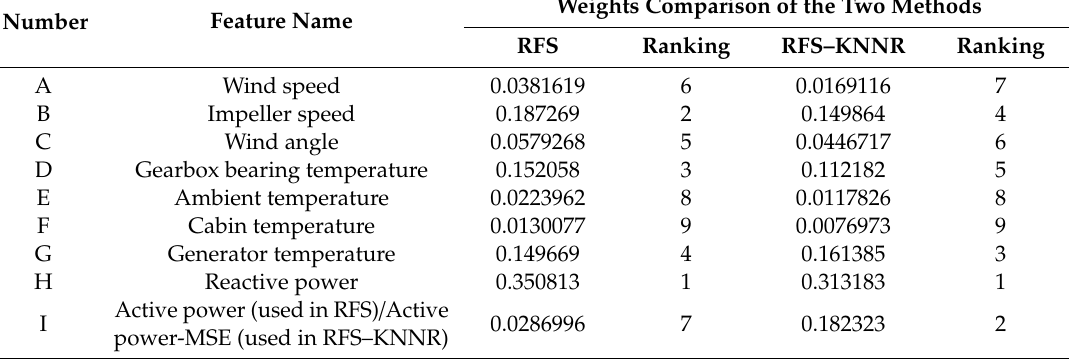
Table 4. Comparison of icing weights for each feature of RF Simplify (RFS) and RFS-KNN Refine (RFS–KNNR).